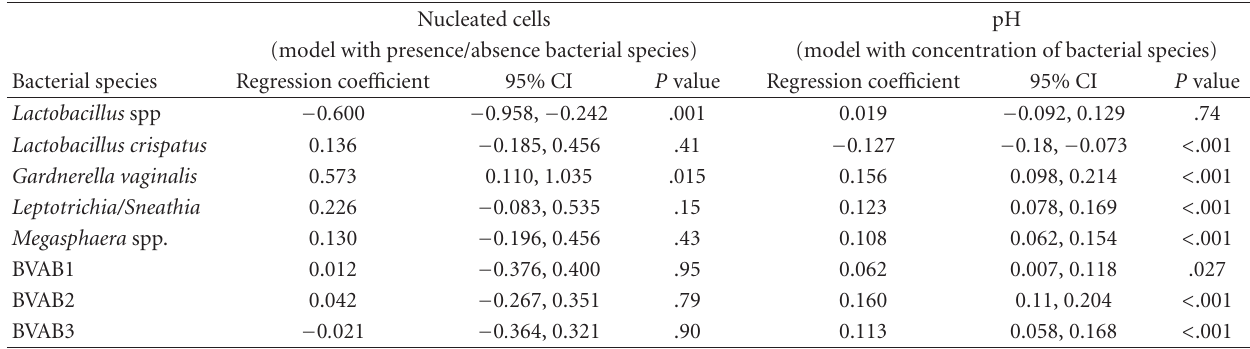
Table 4: Vaginal e ff ects of bacteria: univariate correlation (using linear regression) between presence of bacterial species and log-transformed quantity of nucleated cells in the CVL and between concentration of bacterial species and pH of the vaginal secretions. Nucleated cells pH (model with presence/absence bacterial species) (model with concentration of bacterial species)